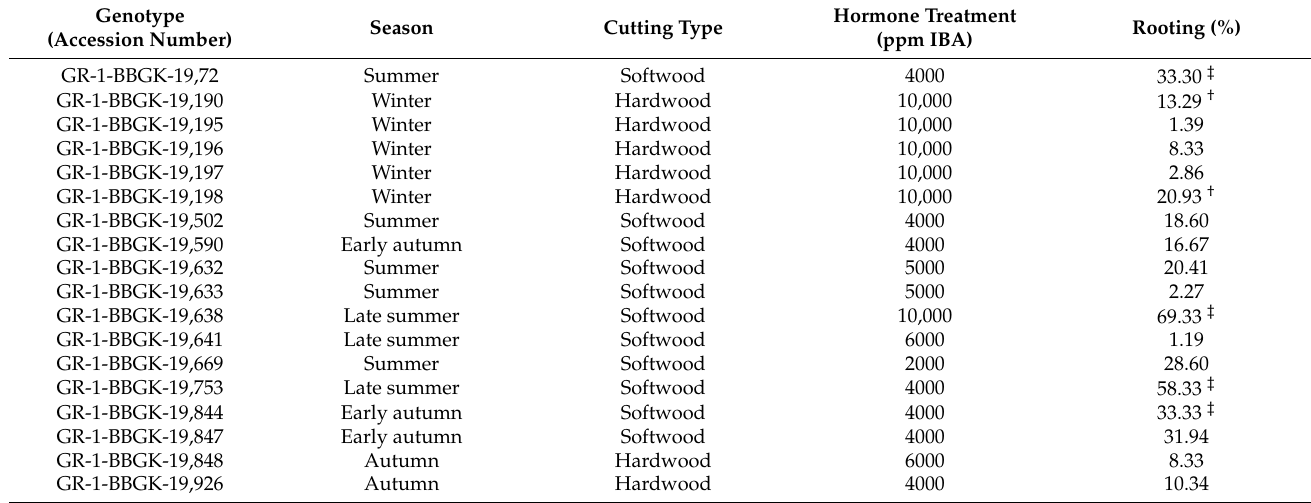
Table 3. Overview of the propagation results achieved in terms of highest rooting frequencies after experimental setups in different seasons (winter 2018, spring–late summer 2019, and early–late autumn 2019) with different types of initial material (softwood or hardwood cuttings) collected directly from wild-growing Greek native populations of Cornus mas (18